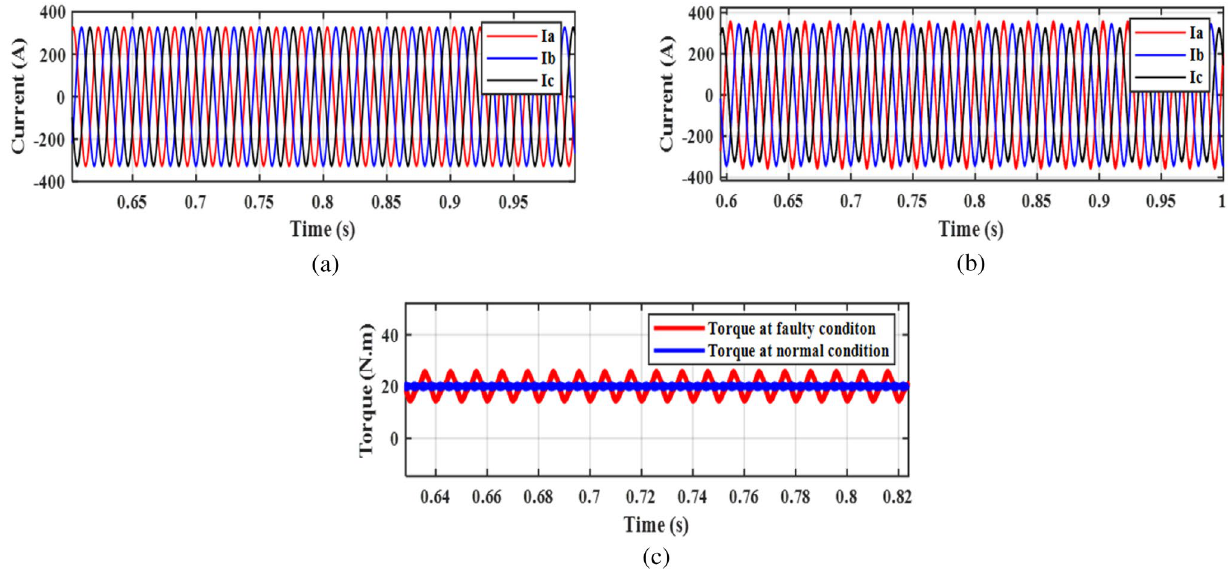
Fig. 1 The output Motor size under regular and faulty operating conditions a stator currents at heathy mode, b stator currents under rf = 10 Ω , 𝜇 = 50 % conditions, c the electromagnetic torque with rf = 1 Ω and 𝜇 = 30